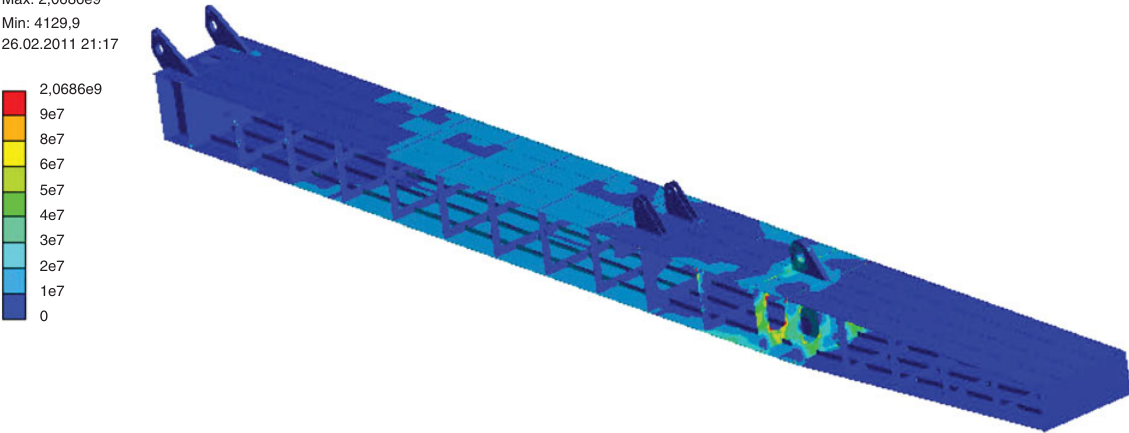
Fig. 6. Trolley with container is between root hinge of console and clamping hinge of console. Stress state of console (Von Misses,